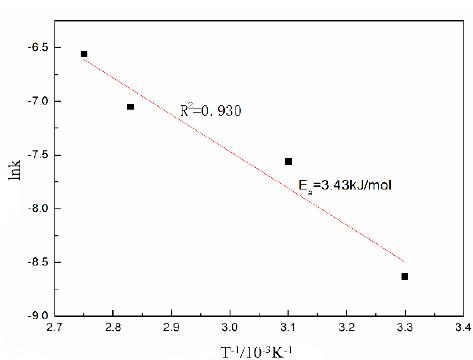
Minerals 2020 , 10 , x FOR PEER REVIEW Figure 9. Arrhenius plot for cobalt leaching. Figure 9. Arrhenius plot for cobalt leaching. Figure 9. Arrhenius plot for cobalt leaching.